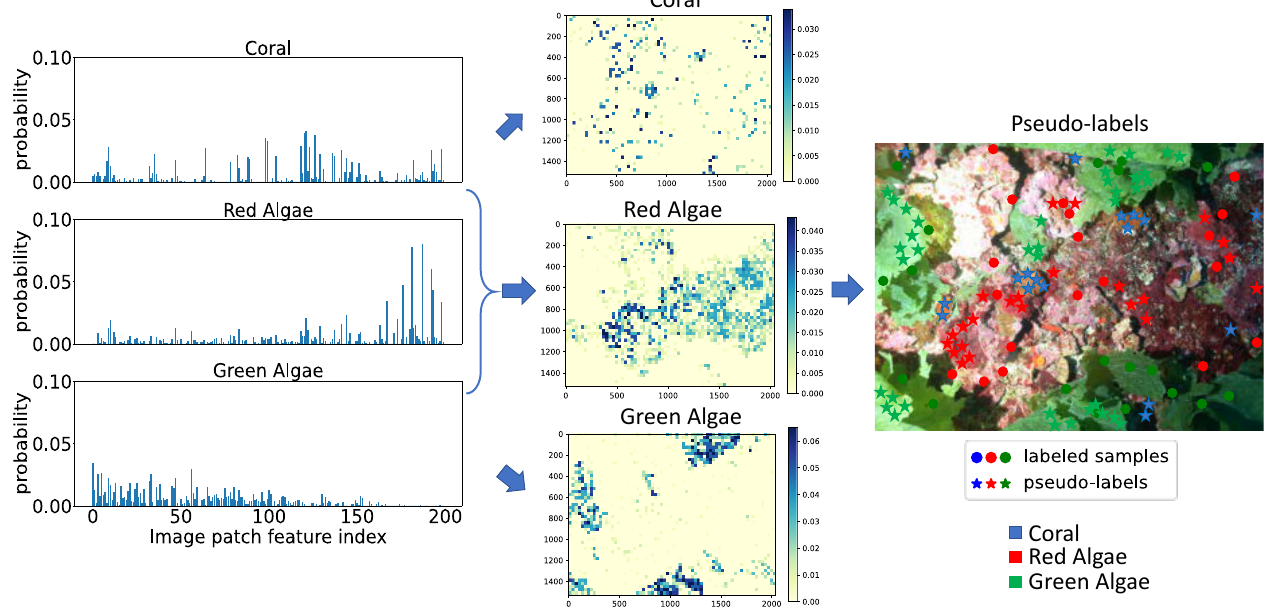
Figure 5. Pseudo-labels